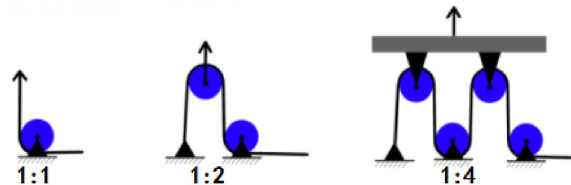
Figure 5. Variable proportion scheme based on pulley combination.